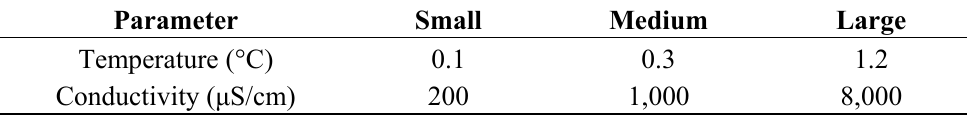
Table 3. Empirically determined coefficients used in Equation (3).